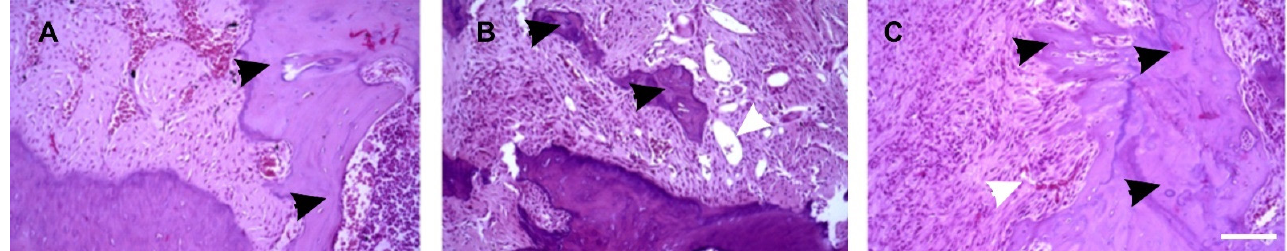
Figure 7. Bone remodeling in hematoxylin-eosin-stained sections of bone defect: ( A ) with no gel implanted, ( B ) cell-free implant and ( C ) cell-seeded implant (white arrows-vessels, black arrows-bone remodeling tissue). Scale bar: 100 mkm.